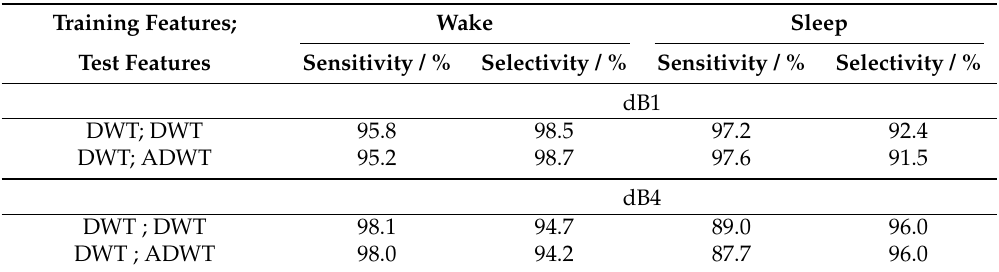
Table 3. Performance of an Artificial Neural Network for determining wake/sleep state from the EEG using DWT spectral